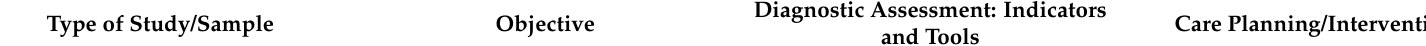
Table 2. Results of the studies and extraction of